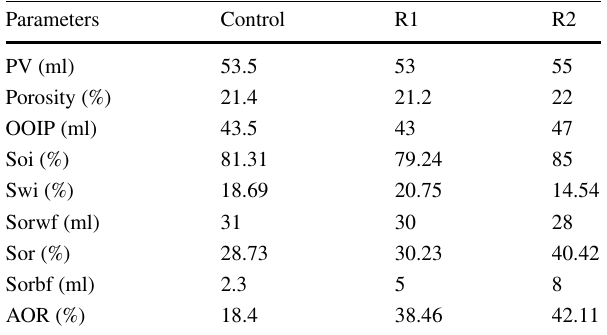
Table 5 Summary of oil recovery in sand-packed column using brine flooding and crude biosurfactant of Pseudoxanthomonas sp. G3